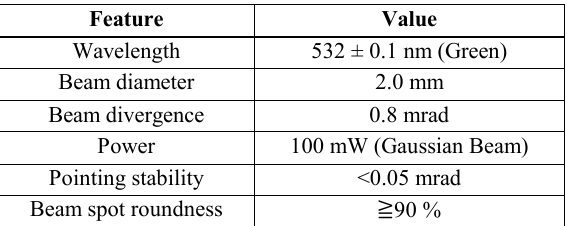
Table 1. Characteristics of the laser pointer.